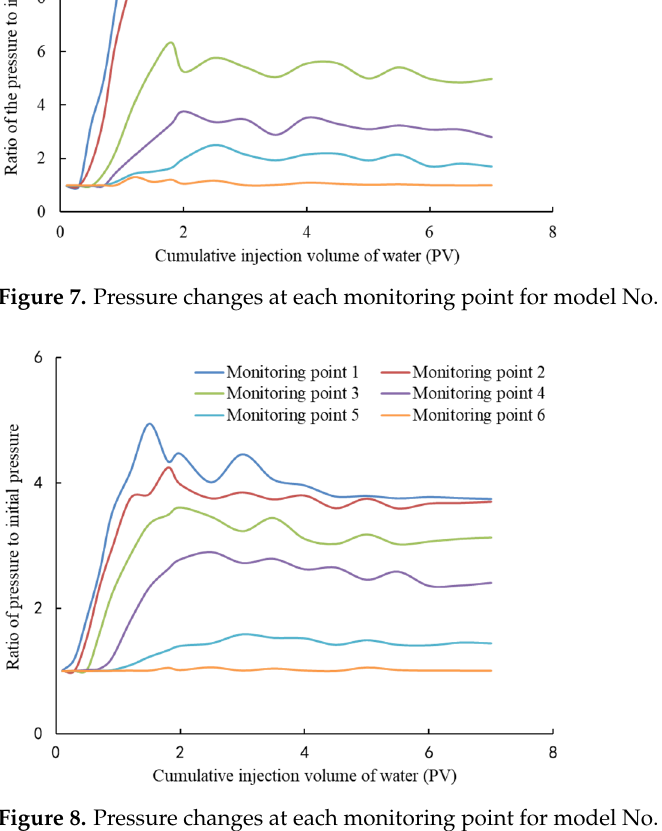
Figure 9. Changes in the displacement differential pressure. 4.3. Selective Plugging in Porous Media As can be seen from Figure 10, the plugging rate of the inorganic particle plugging agent reached 99.18% for the formation with a high permeability, and only 10.1% for the formation with a low permeability. It can be seen that the plugging effect of the inorganic particle plugging agent had a selective plugging effect, the layer with a high permeability was effectively plugged, and a small amount of plugging agent entered the low permea- bility layer.